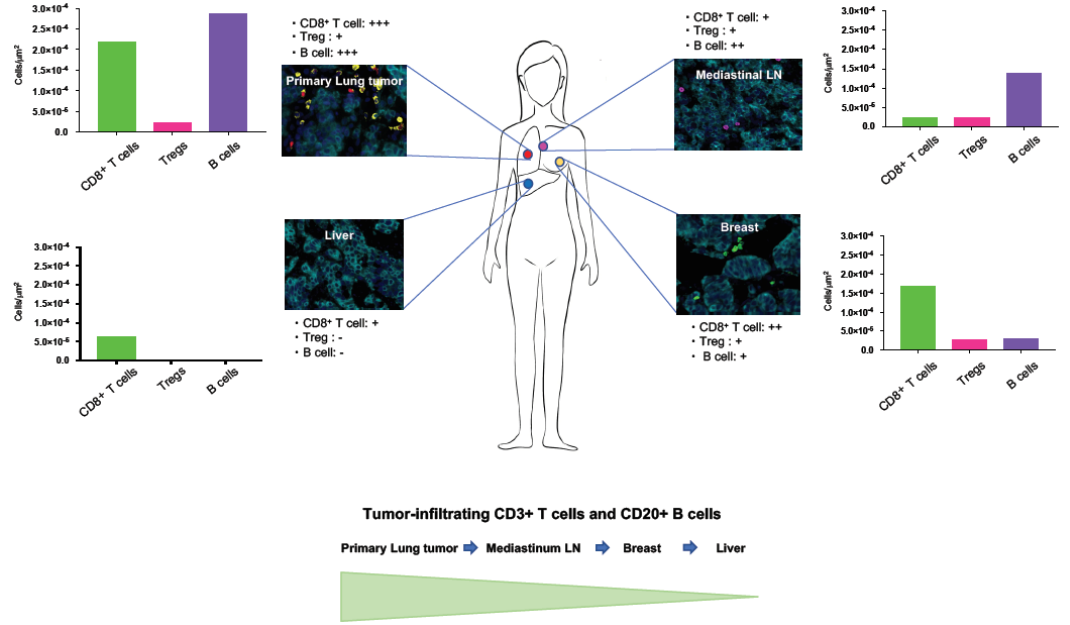
Figure 4. Heterogeneous tumor-immune microenvironments (TIMEs) in LCNEC with ALK rearrangement. Overall schema of TIMEs in primary and metastatic LCNEC with ALK rearrangement is shown. Biopsied lesions and representative images of lung, mediastinal LN, breast and liver tumors are shown. Tumor-infiltrating lymphocyte (TIL) subsets, CD3 + T cells (which include both CD4 + T cells and CD8 + T cells), CD8 + T cells, Tregs, and CD20 + B cells, were counted in primary and metastatic tumors. High-speed scanning of whole slide images was performed on stained tissue sections. Images of full sections were acquired and analyzed with automated quantitative pathology imaging system. All images were analyzed and statistics of the number of each types of cells were generated automatically. CD3 + T cell and CD20 + B cell infiltrations in tumors were decreased with the distance from primary lung lesion.